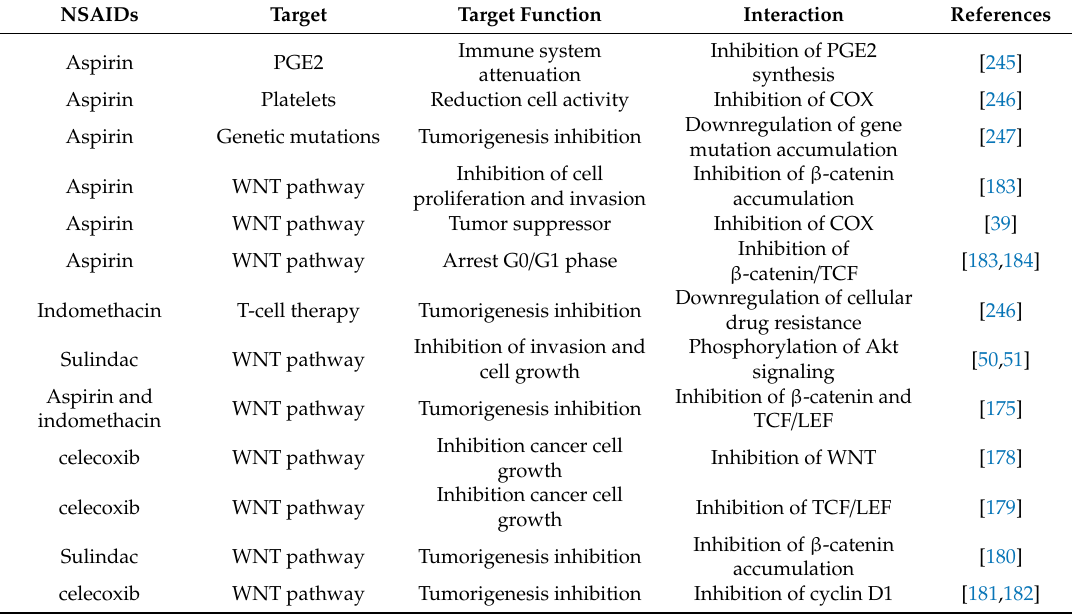
Table 1. Di ff erential e ff ects of NSAIDs in